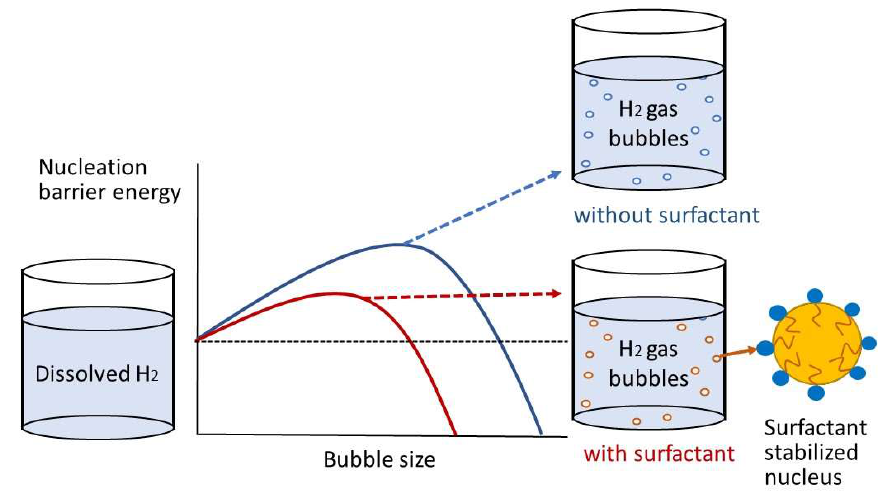
Figure 3. Schematic diagram of the bubble-nucleation-based electrochemical method for PFAS detection. Adapted with permission from Ranaweera et al. [80].